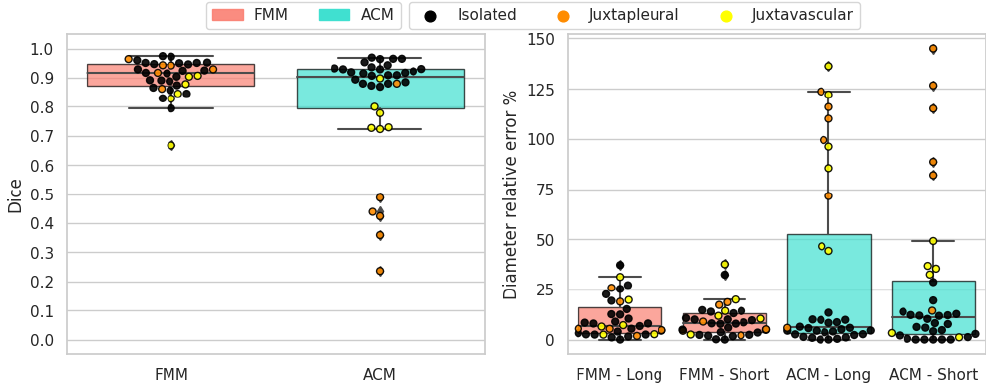
Figure 14. Solid-irregular nodules’ objective evaluation results as boxplots, overlayed with the values of individual cases divided into subcategories.